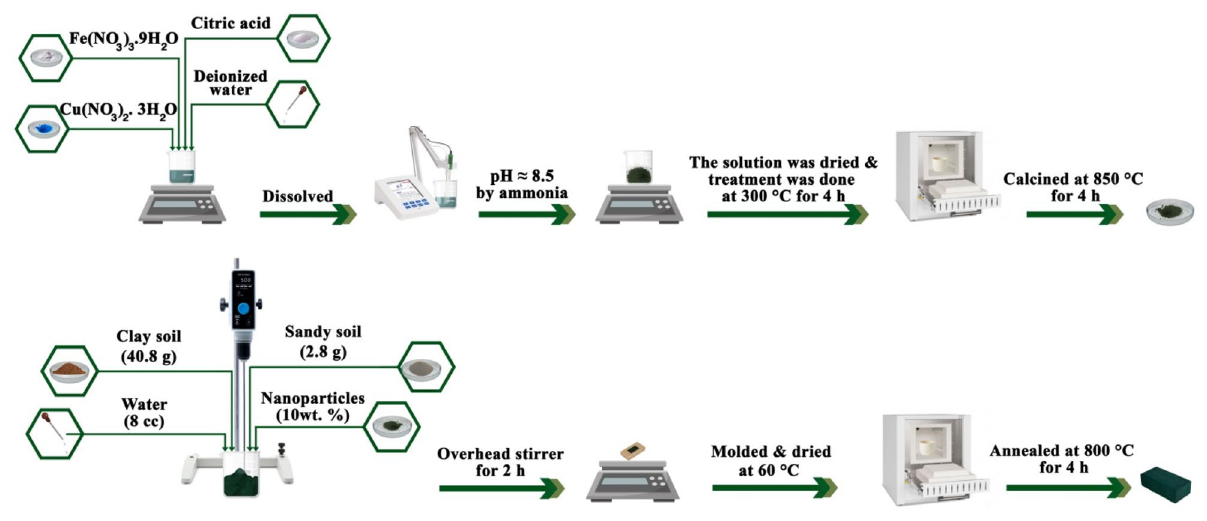
Figure 1. Schematic representation of the experimental